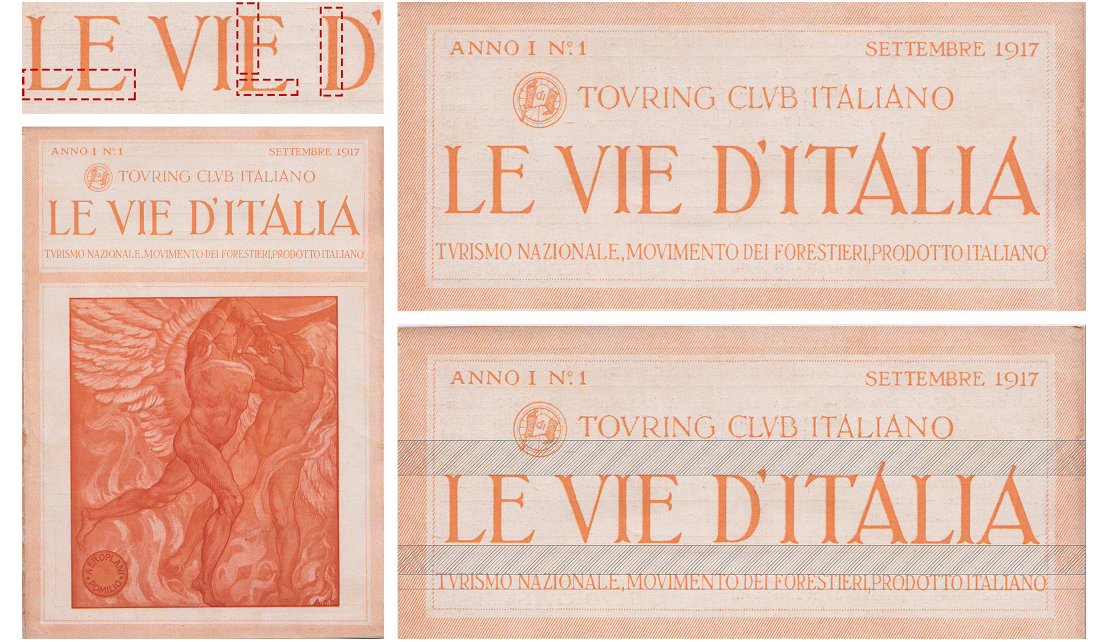
Figure 4. The first cover of Le Vie d’Italia, September 1917.